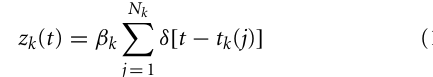
FIGURE 1 | Modular structure of generative model. Our framework proposes voxel-wise or region-wise fitting of a non-linear model to fMRI data. The model comprises separate modules which characterize a Neural Response Function (NRF) and a Hemodynamic Response Function (HRF). The NRF is based on a non-linear parametric form, which will vary depending on the application domain, relating neuronal activity z to known stimulus characteristics, c k , and unknown neuronal